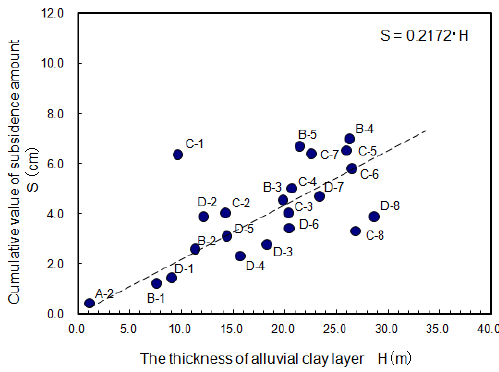
Figure 11. Cumulative value of land subsidence and thickness of the alluvial clay